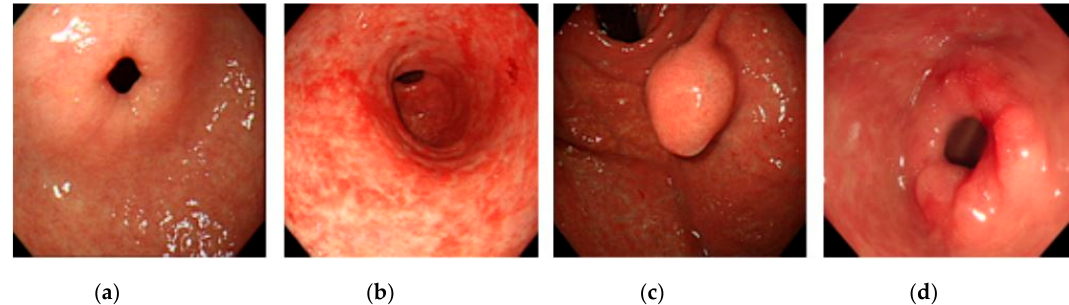
Figure 2. Normal and abnormal gastroscopy images in the dataset: ( a ) normal; ( b ) gastritis; ( c ) gastric SMT; and ( d ) gastric cancer.